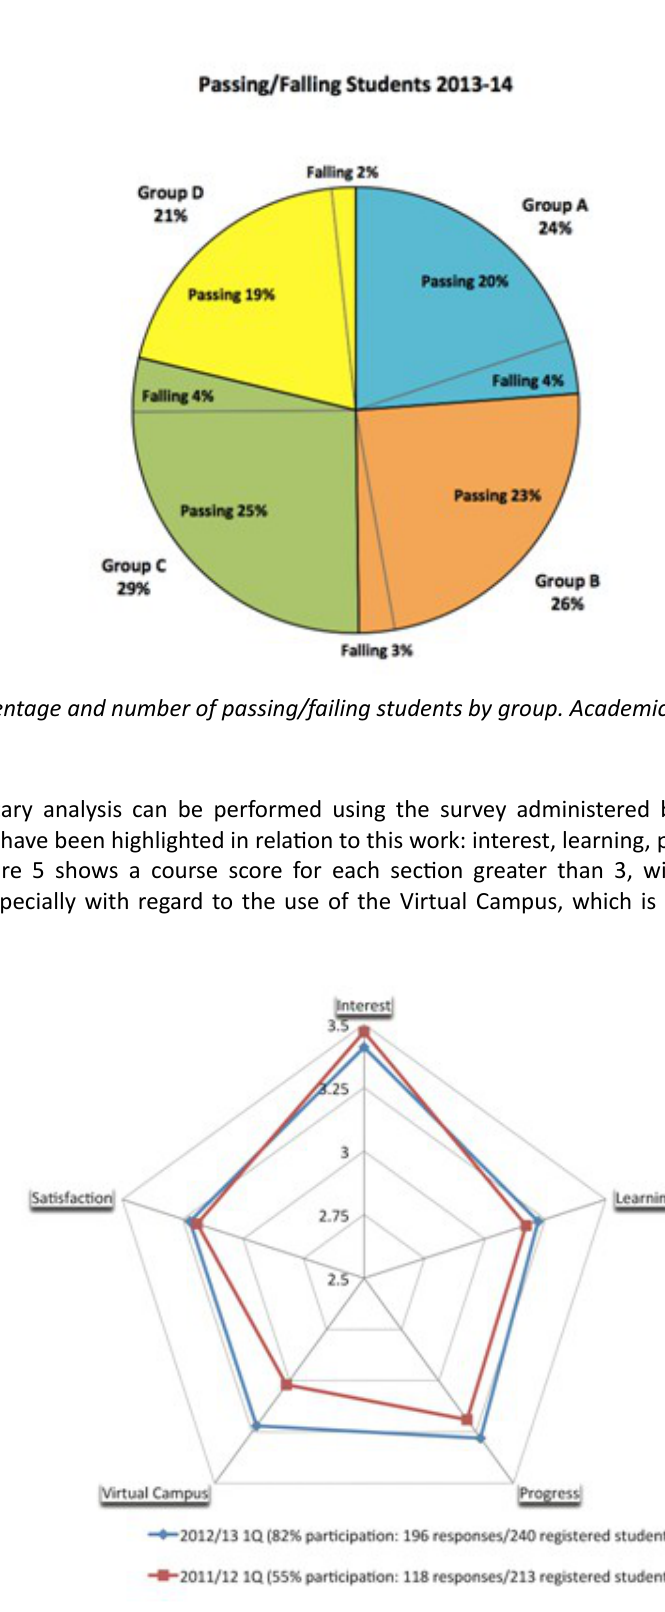
Figure 5. Evoluton of the ofcial course survey administered by the University (evaluaton scale: 1–Strongly disagree to 5–Strongly agree)